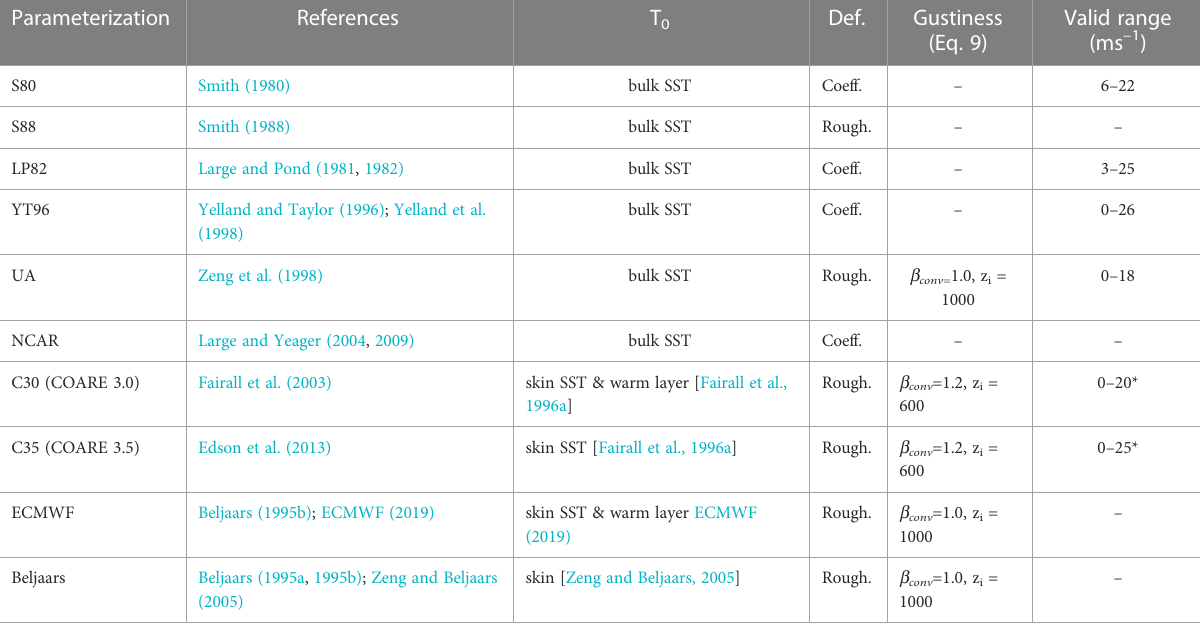
TABLE 1 Summary of parameterizations implemented in AirSeaFluxCode as documented or implemented by the parameterization developers.